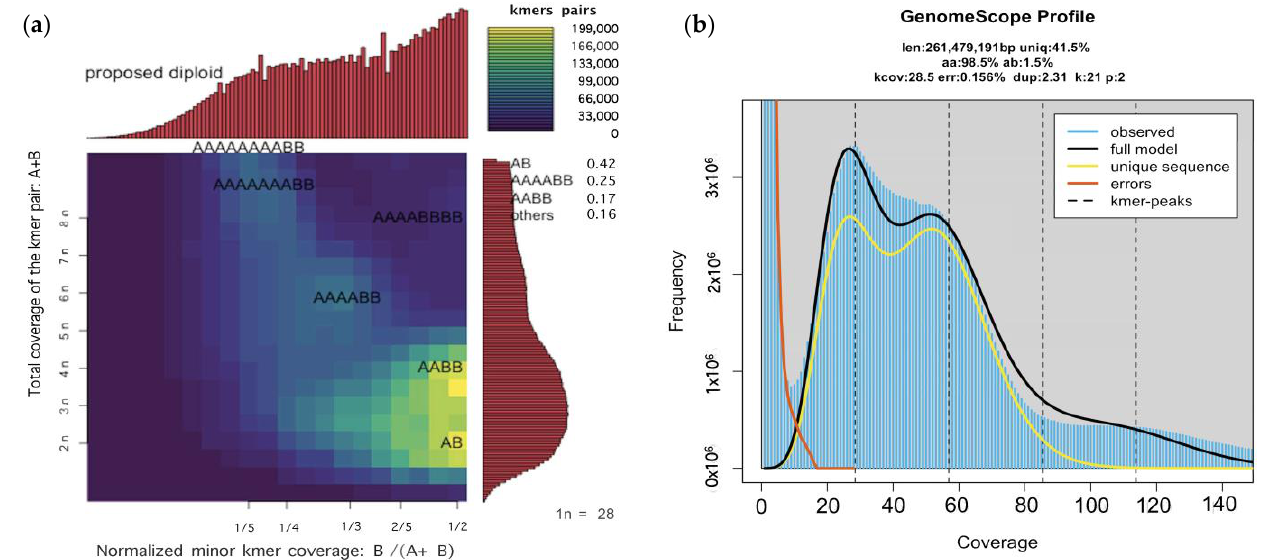
Figure 2. Genome ploidy estimation of Pratylenchus scribneri genome assembly: ( a ) Smudgeplots showing the coverage and distribution of k-mer pairs that fit to diploid genome model; ( b ) GenomeScope k-mer (k = 21) profile plot of the P. scribneri showing the fit of the GenomeScope model (black) to the observed k-mer frequencies (blue) with two major peaks.